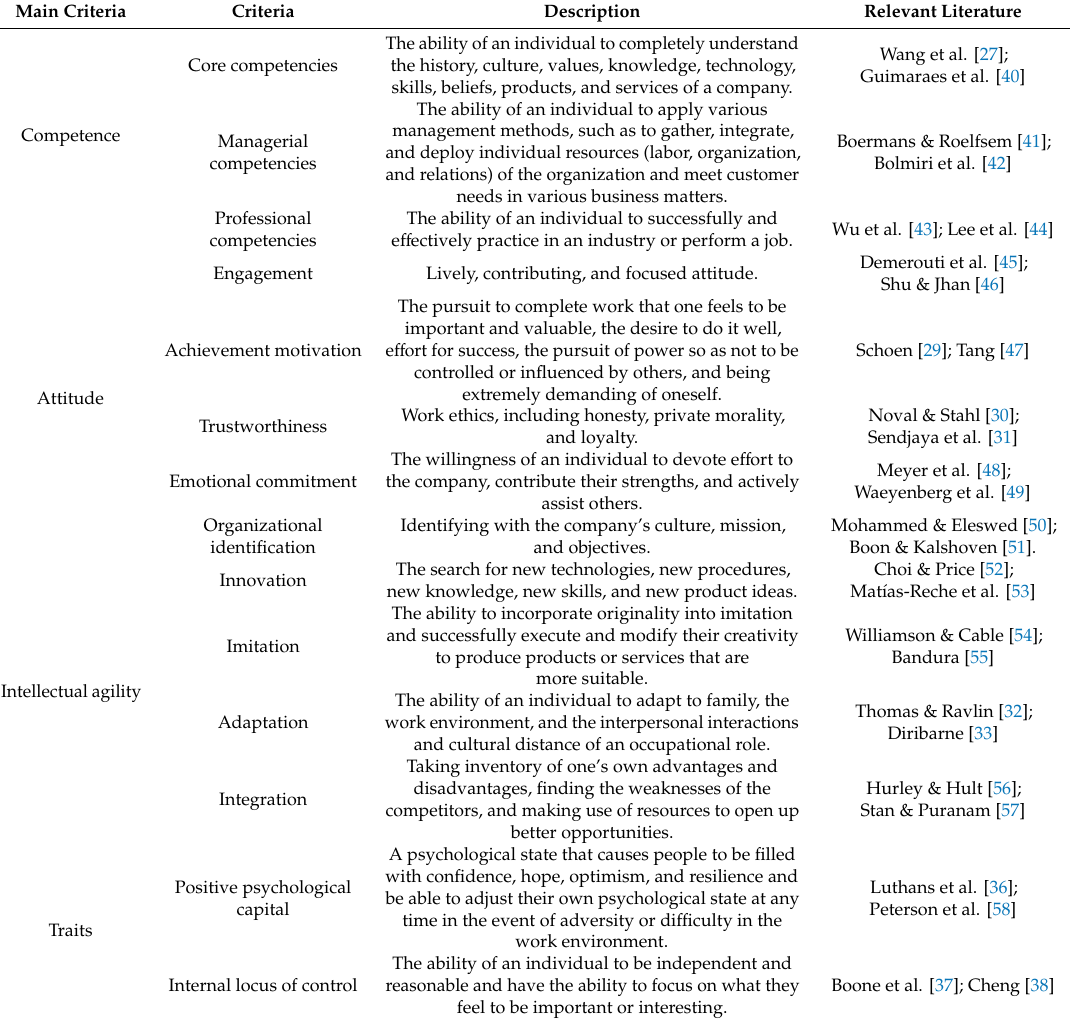
Table 1. Selection factors for middle and top